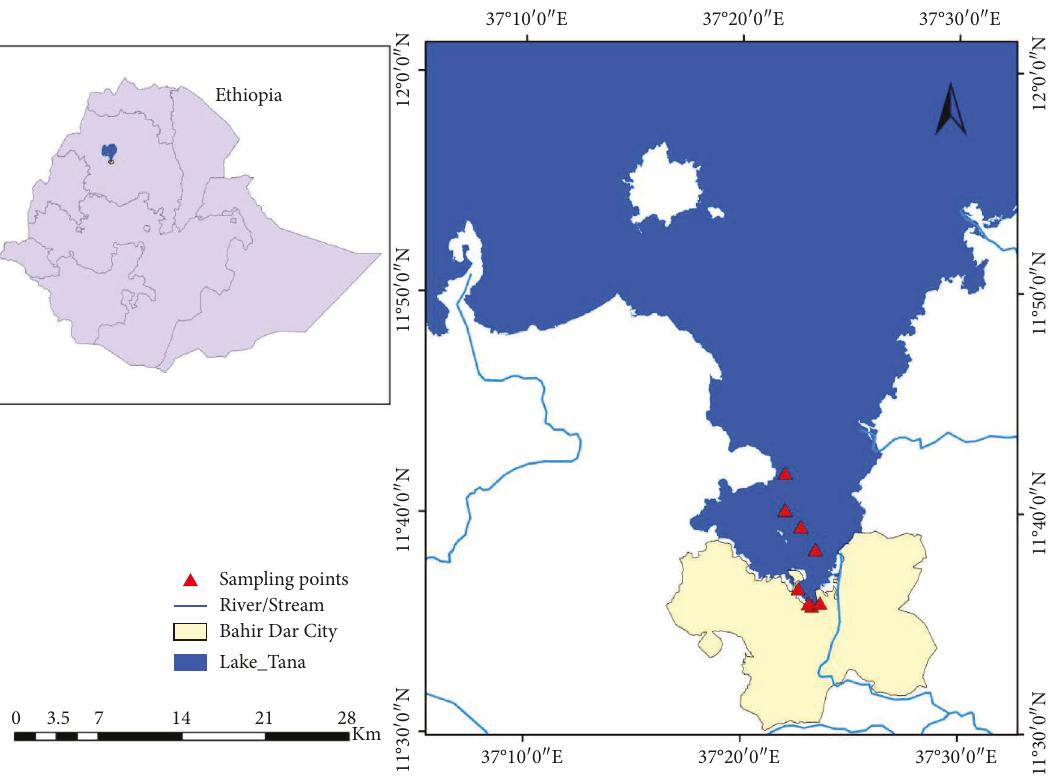
Figure 1: Map showing sampling sites at the Southern Gulf of Lake